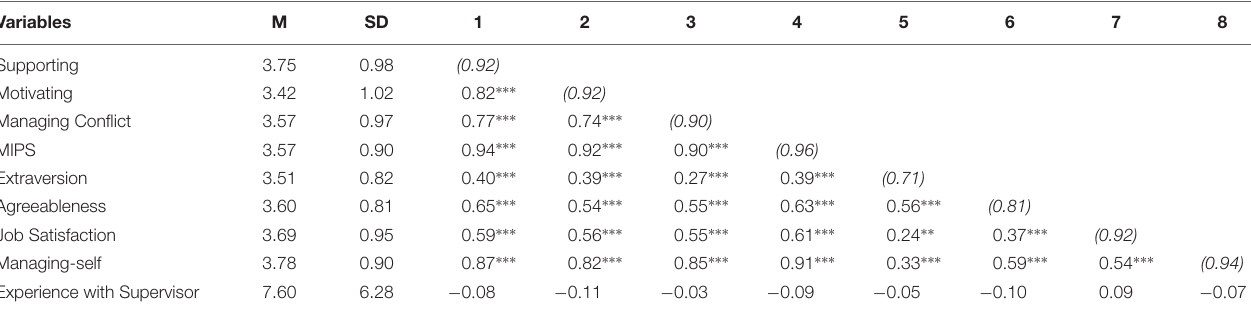
TABLE 1 | Means, standard deviations, reliabilities and correlations – Study